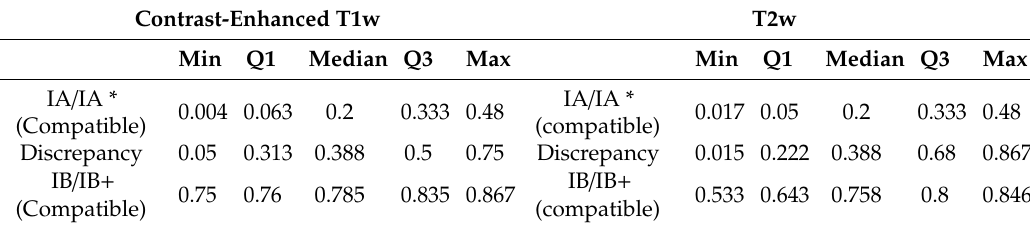
Figure 4. Box and Whisker Plot of data from radiologists′ diagnoses and pathological stages. Table 5. Results of AI interpretation and pathological stages (contrast-enhanced T1w and T2w).